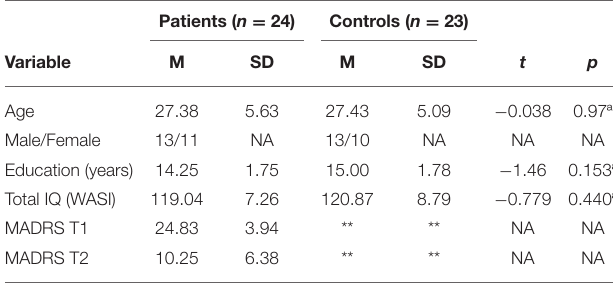
TABLE 1 | Clinical and demographic variables for the patient and control groups at